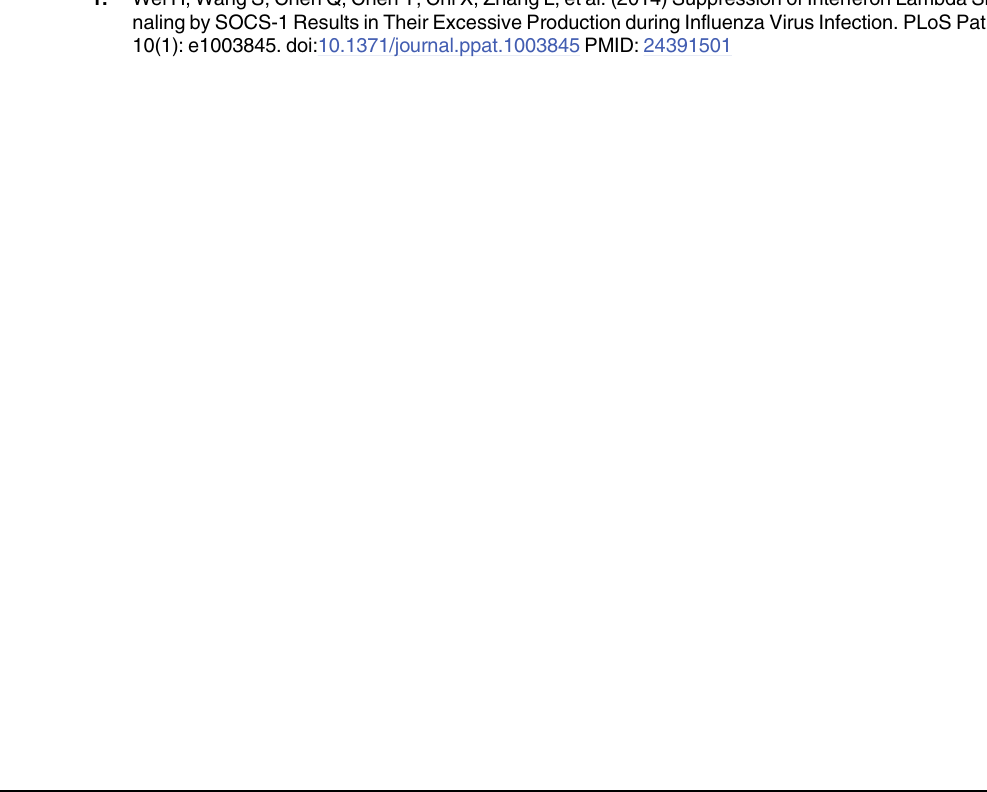
S1 Fig. Raw data for Fig 1G. A549 cells expressing shRNAs targeting RIG-I or luciferase (Luc) were infected with or without WSN virus, and then the expression of IL-28A/B, RIG-I and IL- 29 was determined by RT-PCR and examined by agarose gel electrophoresis as indicated. (PPT) S2 Fig. Raw data for Fig 2B. A549 cells infected with WSN virus (MOI = 1) for 15 h or non- infected were stimulated with human IL-28A for indicated time as described in Fig 2B. Cell lysates were analyzed by Western blotting using anti- β -actin, anti-phosphorylated STAT1 (Tyr701), anti-STAT1 and anti-viral NP antibodies. (PPTX) S3 Fig. Raw data for Fig 5D. A549 cell lines stably expressing STAT1-WT, STAT1-2C or empty vector (EV) were infected with or without WSN virus for 15 h. mRNA levels of IL-28A/ B, GAPDH and IL-29 were measured by RT-PCR and examined by agarose gel electrophoresis. (PPT) S4 Fig. Raw data for Fig 8F. WT and TG mice were infected with or without WSN virus intra- nasally (1×10 5 PFU). On Day 3 p.i., lungs were lysed and expression of IL-28A/B, mSOCS1 and β -actin was examined by RT-PCR followed by agarose gel electrophoresis.